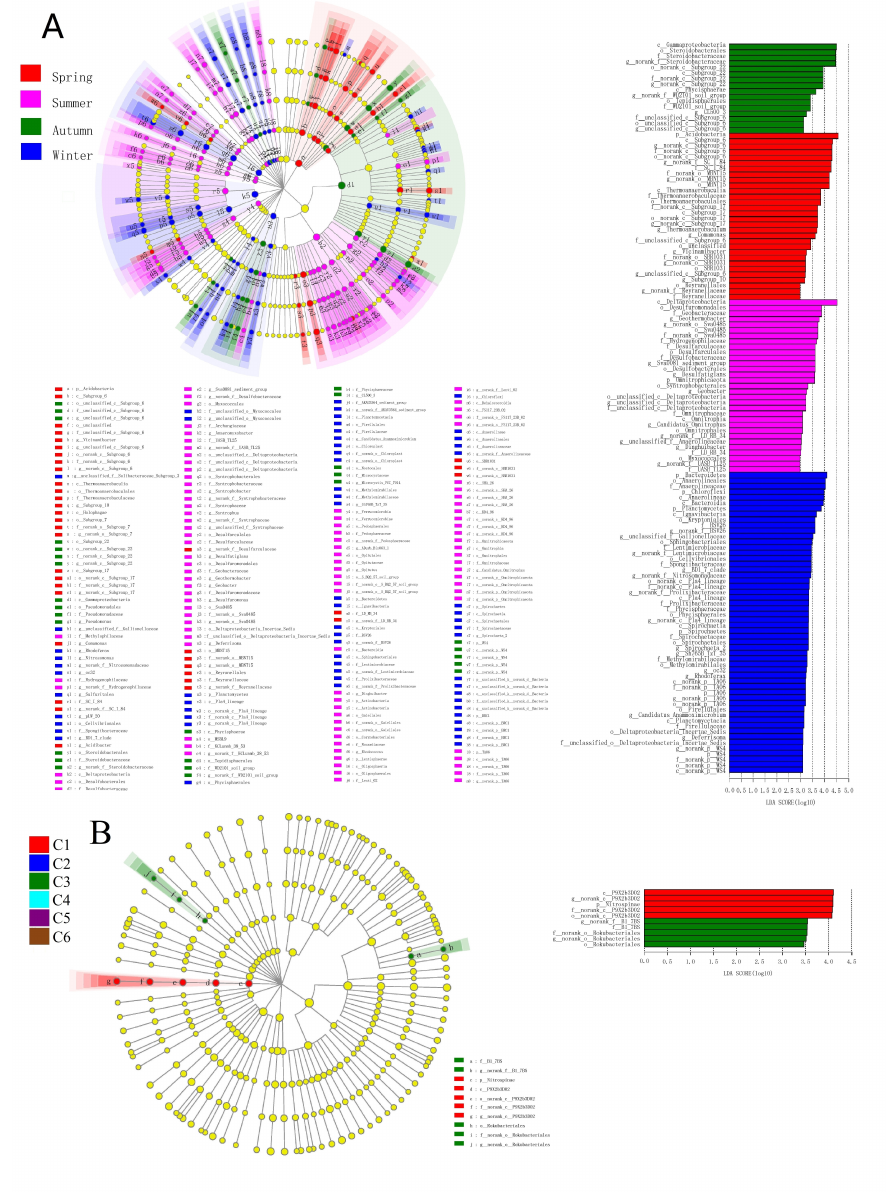
Figure 5. ( A ) Cladogram showing the phylogenetic distribution of the bacterial lineages associated with sediment for the 24 samples in di ff erent seasons and locations. The phylum, class, order, family, and genus levels are listed in order from the inside to the outside of the cladogram, and are used to determine the most likely to explain the di ff erence between taxa groups or classified terrain types. ( B ) Indicator bacteria with linear discriminant analysis (LDA) scores of 2 or greater in bacterial communities associated with sediments that di ff ered among seasons and points. Di ff erent-colored regions represent di ff erent constituents, whereas the yellow circles represent taxa with no significant di ff erences in the